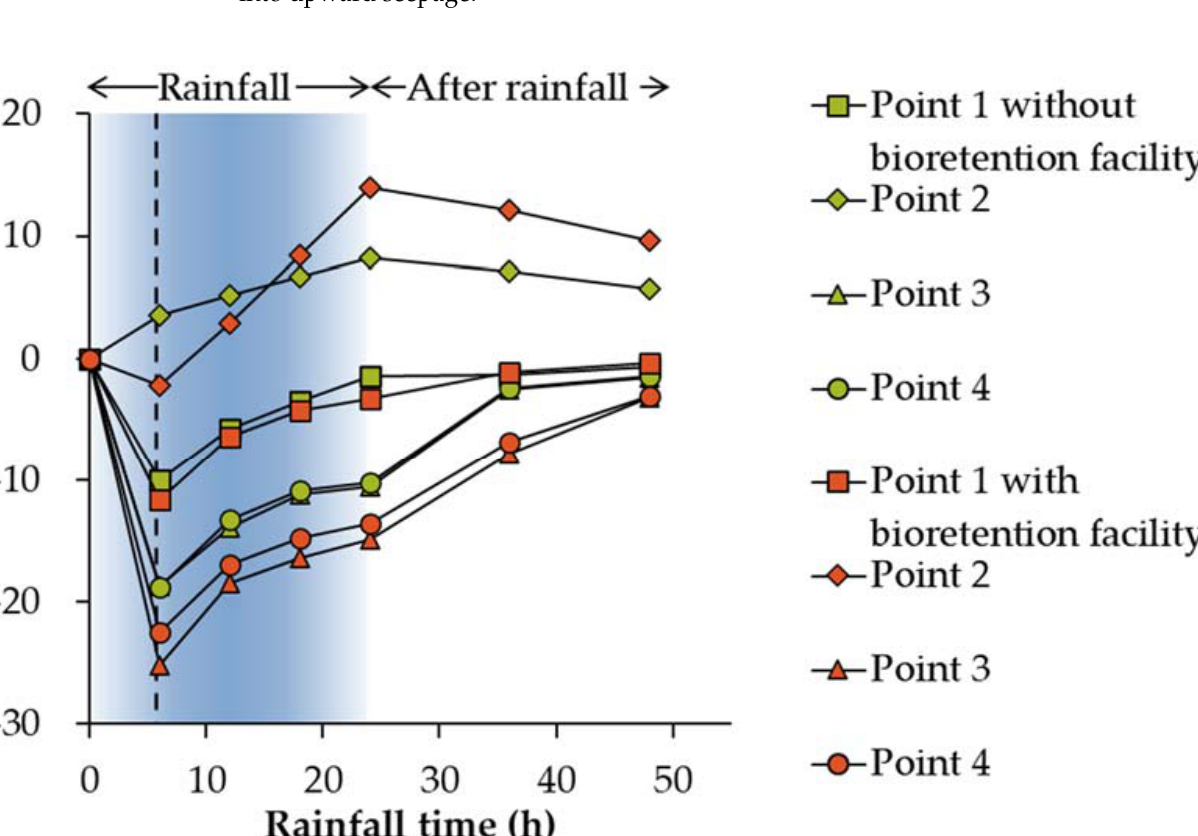
Figure 8 is a graph of the water flow velocity at different control points. In the figure, a positive value means that the direction of water flow is upward along the Z -axis, and a negative value means that the direction of water flow is downward along the Z -axis. The flow velocity curves of different control points were analyzed. In the initial rainfall period of 0–6 h, the flow velocity of control point 1 increased to 9.97 cm/d, control point 2 to 3.52 cm/d, control point 3 to 18.63 cm/d, and control point 4 to 18.74 cm/d. The flow velocity at all four control points increased linearly with the rainfall time, indicating that the slope soil saturated faster in the early rainfall stage, the flow velocity increased greatly, and the water flow at each control point flowed down to the unsaturated soil along the gravity direction. In the middle and late period of rainfall (6–24 h), the flow velocity at control point 1, control point 3, and control point 4 decreased gradually from 9.97 cm/d to 1.45 cm/d, 18.63 cm/d to 10.57 cm/d, and from 18.74 cm/d to 10.19 cm/d under the condition of no biological retention facilities. The flow velocity at control point 2 gradually increased from 3.52 cm/d to 8.21 cm/d, and meanwhile, the flow at control point 2 changed into upward seepage.